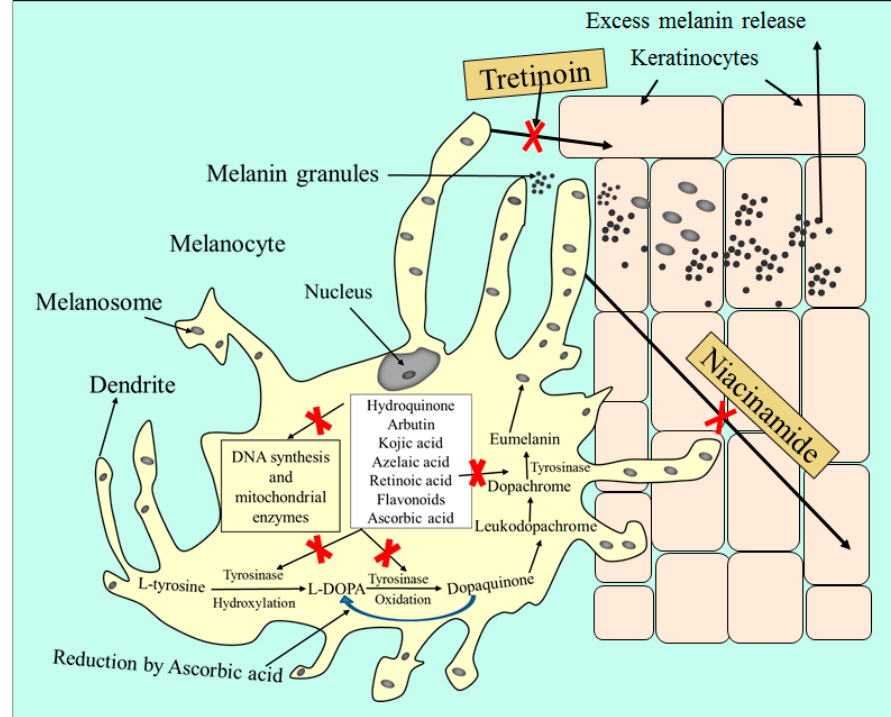
Figure 2. The mechanism of action of anti-hyperpigmentation drugs via topical application.